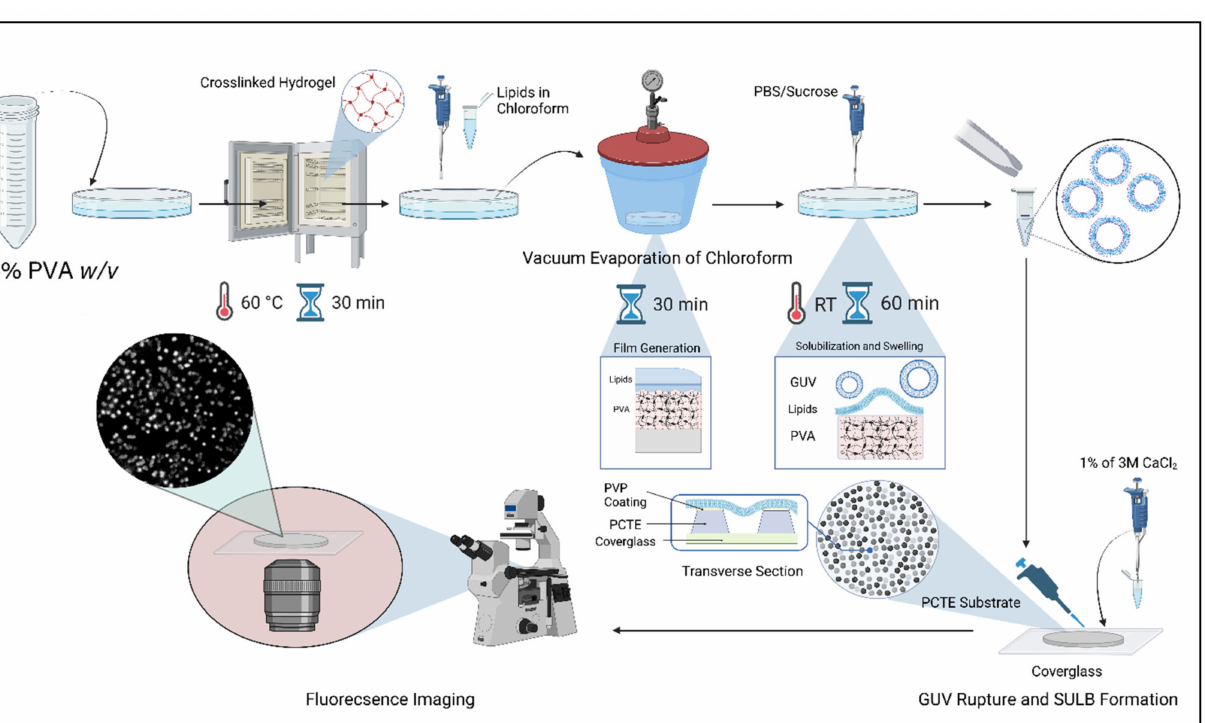
Figure 1. Preparation of suspended lipid bilayer on PCTE substrate. The schematic shows the procedure for SULB platform preparation. GUVs prepared with gel-assisted technique are ruptured and spread over PCTE polymeric substrate placed on a